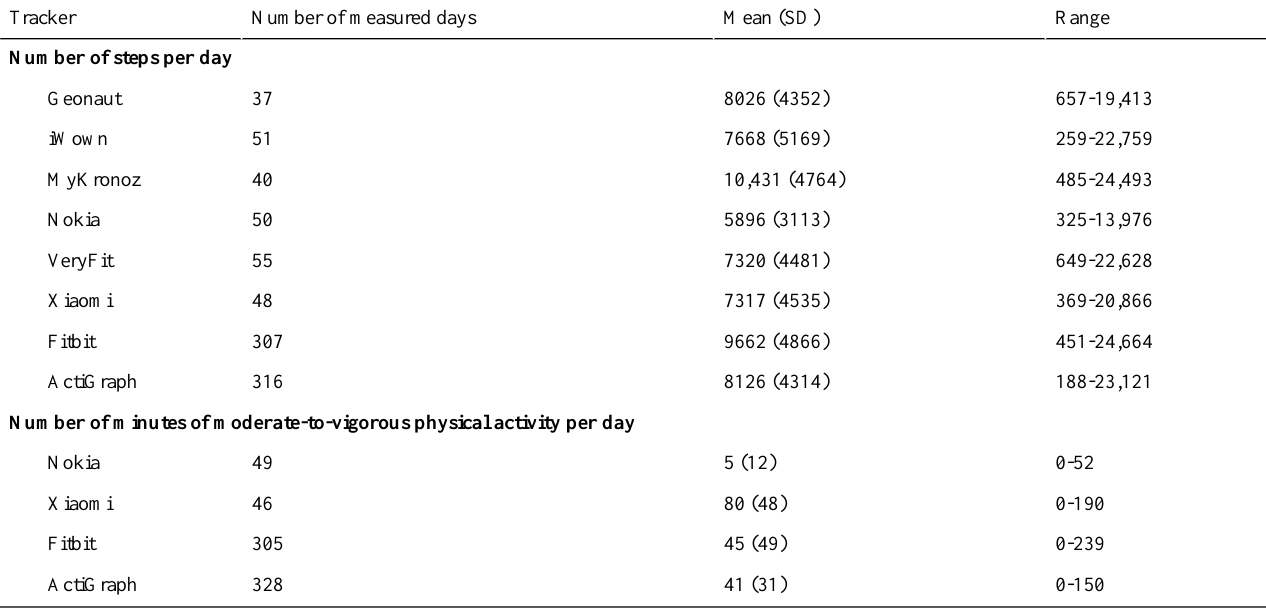
RangeMean (SD)Number of measured daysTracker